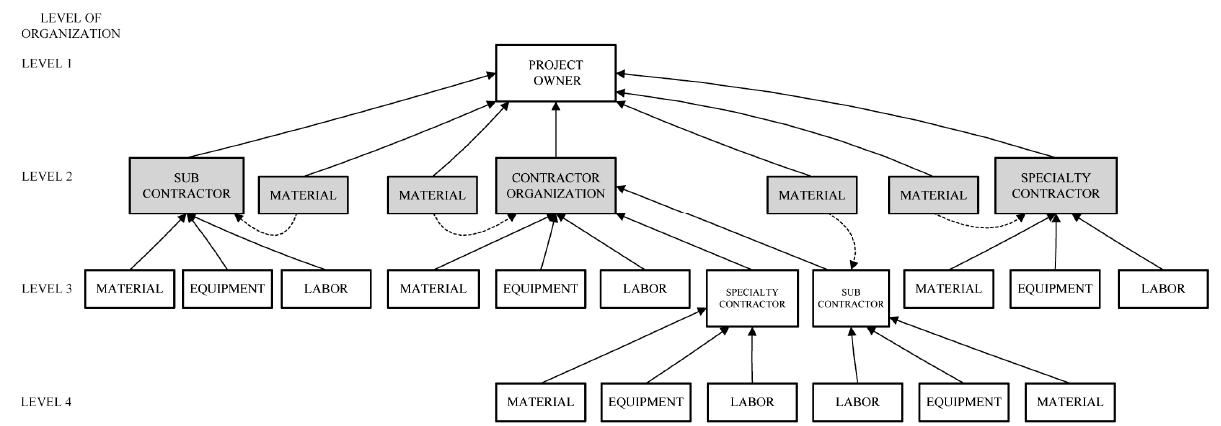
Fig. 3. Distinctive pattern Type 2 of construction supply chains (Susilawati